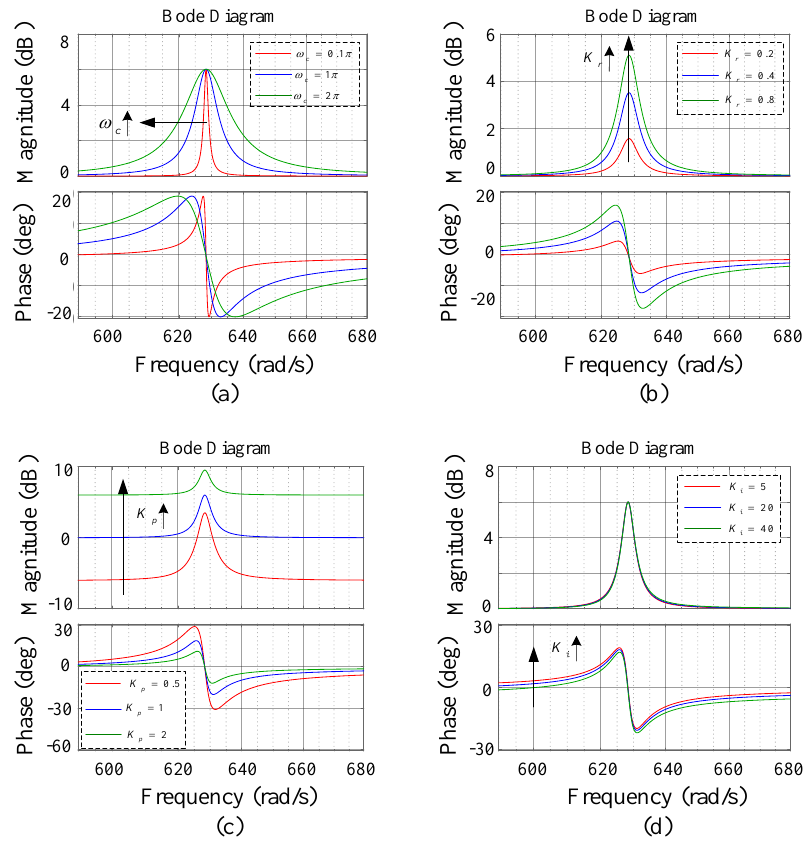
Figure 10. Frequency response output of the PIR controller. ( a ) ω c ; ( b ) K r ; ( c ) K p ; ( d ) K i .